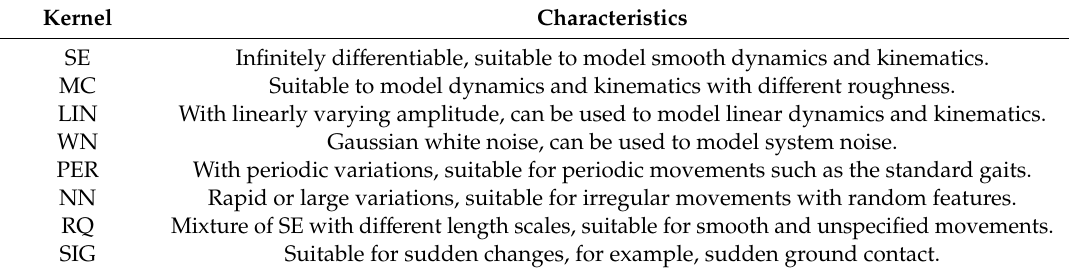
Table 1. Characteristics of some commonly used kernel functions. Note: SE, squared exponential; MC, Matern class; LIN, linear; WN, white noise; PER, periodic; NN, neural network; RQ, rational quadratic; SIG, sigmoid.